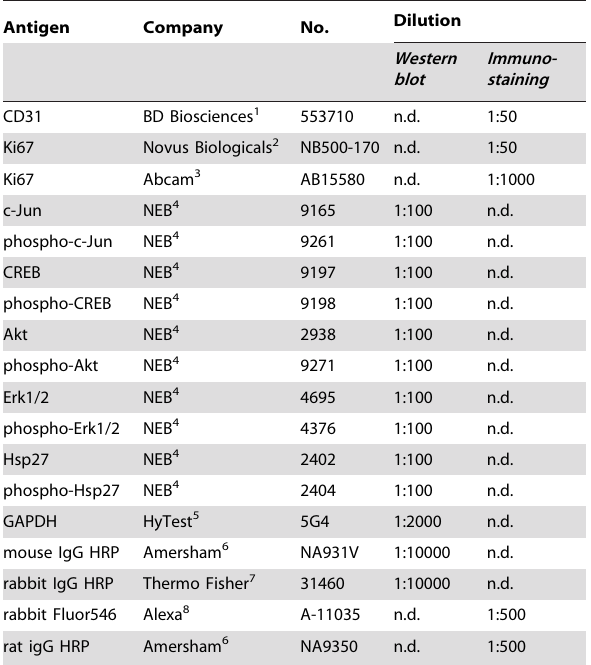
Table 1. List of